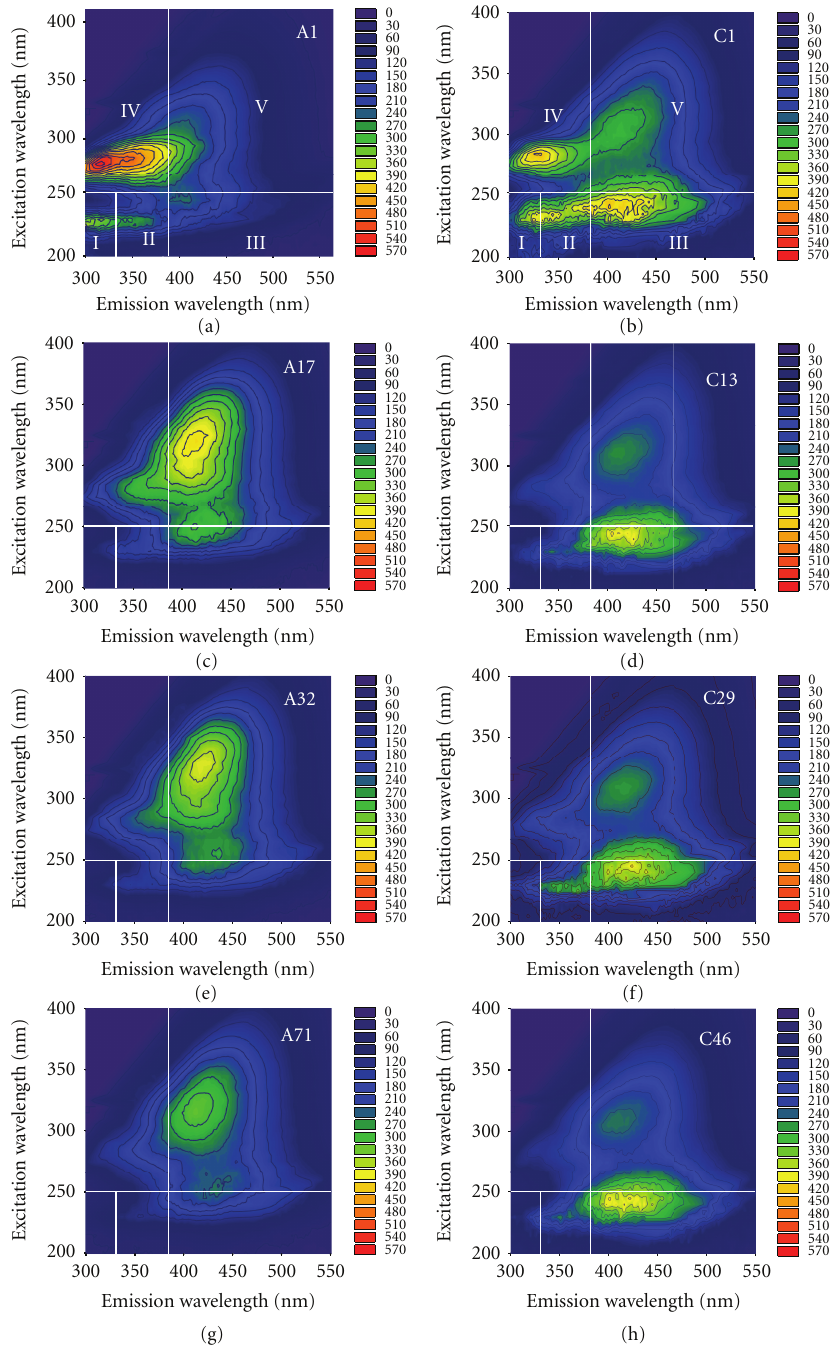
Figure 2: Excitation-emission matrix (EEM) spectra of DOM from treatment A (pig manure + sawdust) on days 1, 17, 32, and 71 (A1, A17, A32, and A71) and treatment C (cattle manure + sawdust) on day 1, 13, 29, and 46 (C1, C13, C29, and C46).